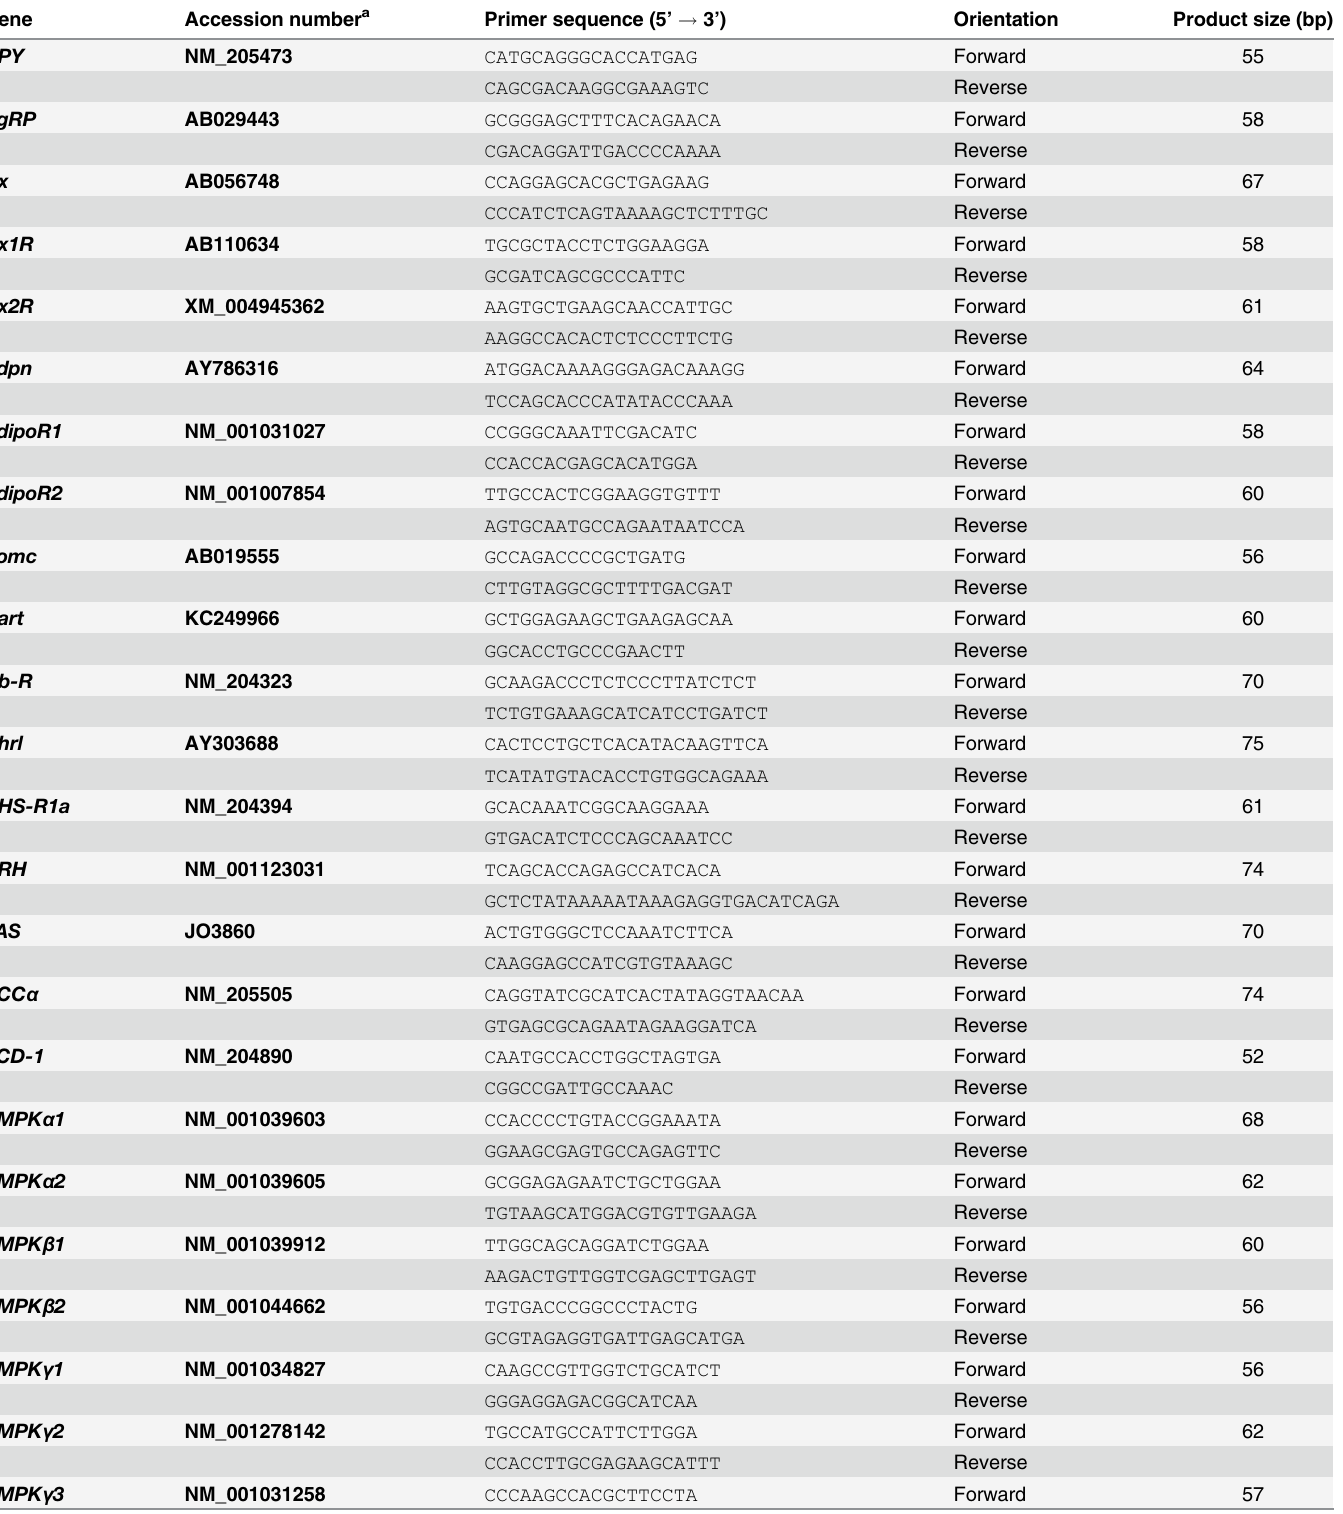
Table 1. Oligonucleotide qPCR